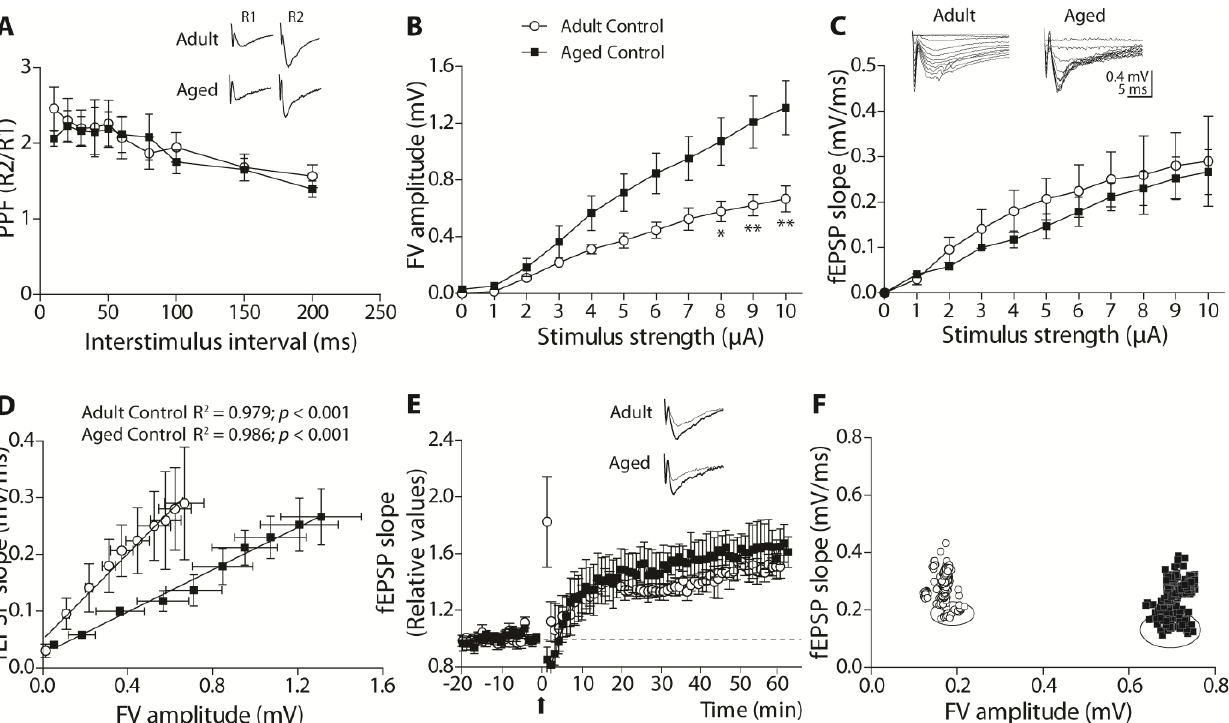
Figure 4. Comparison of synaptic transmission and plasticity mechanisms in adult and aged female degus. ( A ) The PPF plot shows the ratio of R2 versus R1 (R2/R1) slopes, recorded at several time intervals (20, 30, 50, 60, 80, 100, 150, and 200 ms). Inset: representative traces of R1 and R2 evoked fEPSPs separated by 20 ms. The I − O curves of fiber volley amplitudes ( B ) and fEPSP slopes ( C ) against stimulus intensity. Inset: representative traces of postsynaptic potentials evoked by increasing stimulus intensities (μA). Data analysis by two - way ANOVA followed by Bonferroni’s post hoc test. ( D ) The correlation plot of FV amplitudes and fEPSP slopes, each data adjusted by linear regression and analyzed by ANCOVA. ( E ) LTP plot shows the fEPSP slopes after TBS (arrow) normalized to the average of slopes before TBS. ( F ) Correlation plot of FV amplitudes and fEPSP slopes obtained before TBS (pre-TBS, symbols within circle) and after TBS (post − TBS, symbols alone). Comparison of 10 last min by t − test. Data represent the mean ± SEM obtained from n = 6 degus per group. At least three slices from each animal were considered replicates, averaged together, and counted as n = 1. *p < 0.05, **p < 0.01.